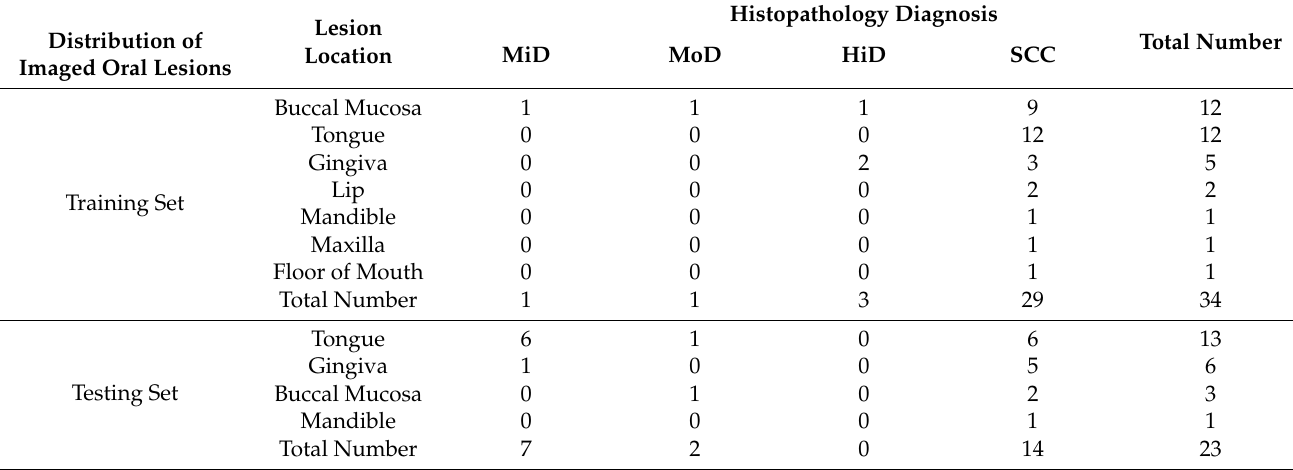
Total NumberDistribution of